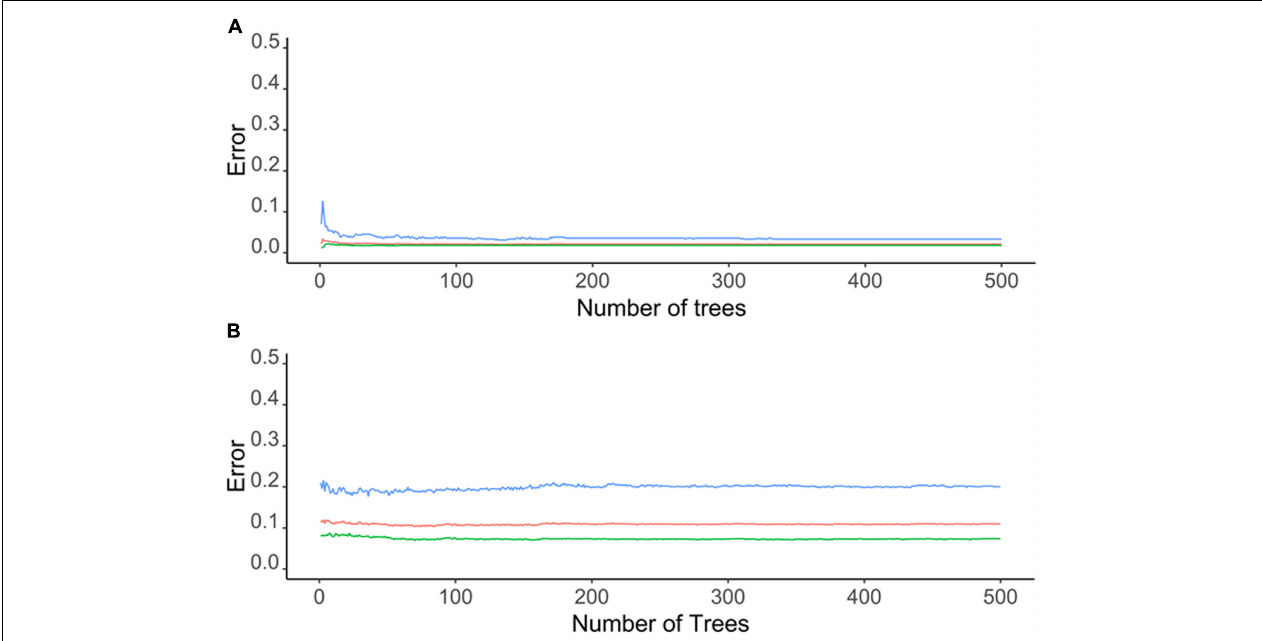
FIGURE 3 | Graphs depicting out of bag (OOB) error of a random forest model for (A) C . pipiens and (B) C . quinquefasciatus occurrence with environmental parameters as predictor.